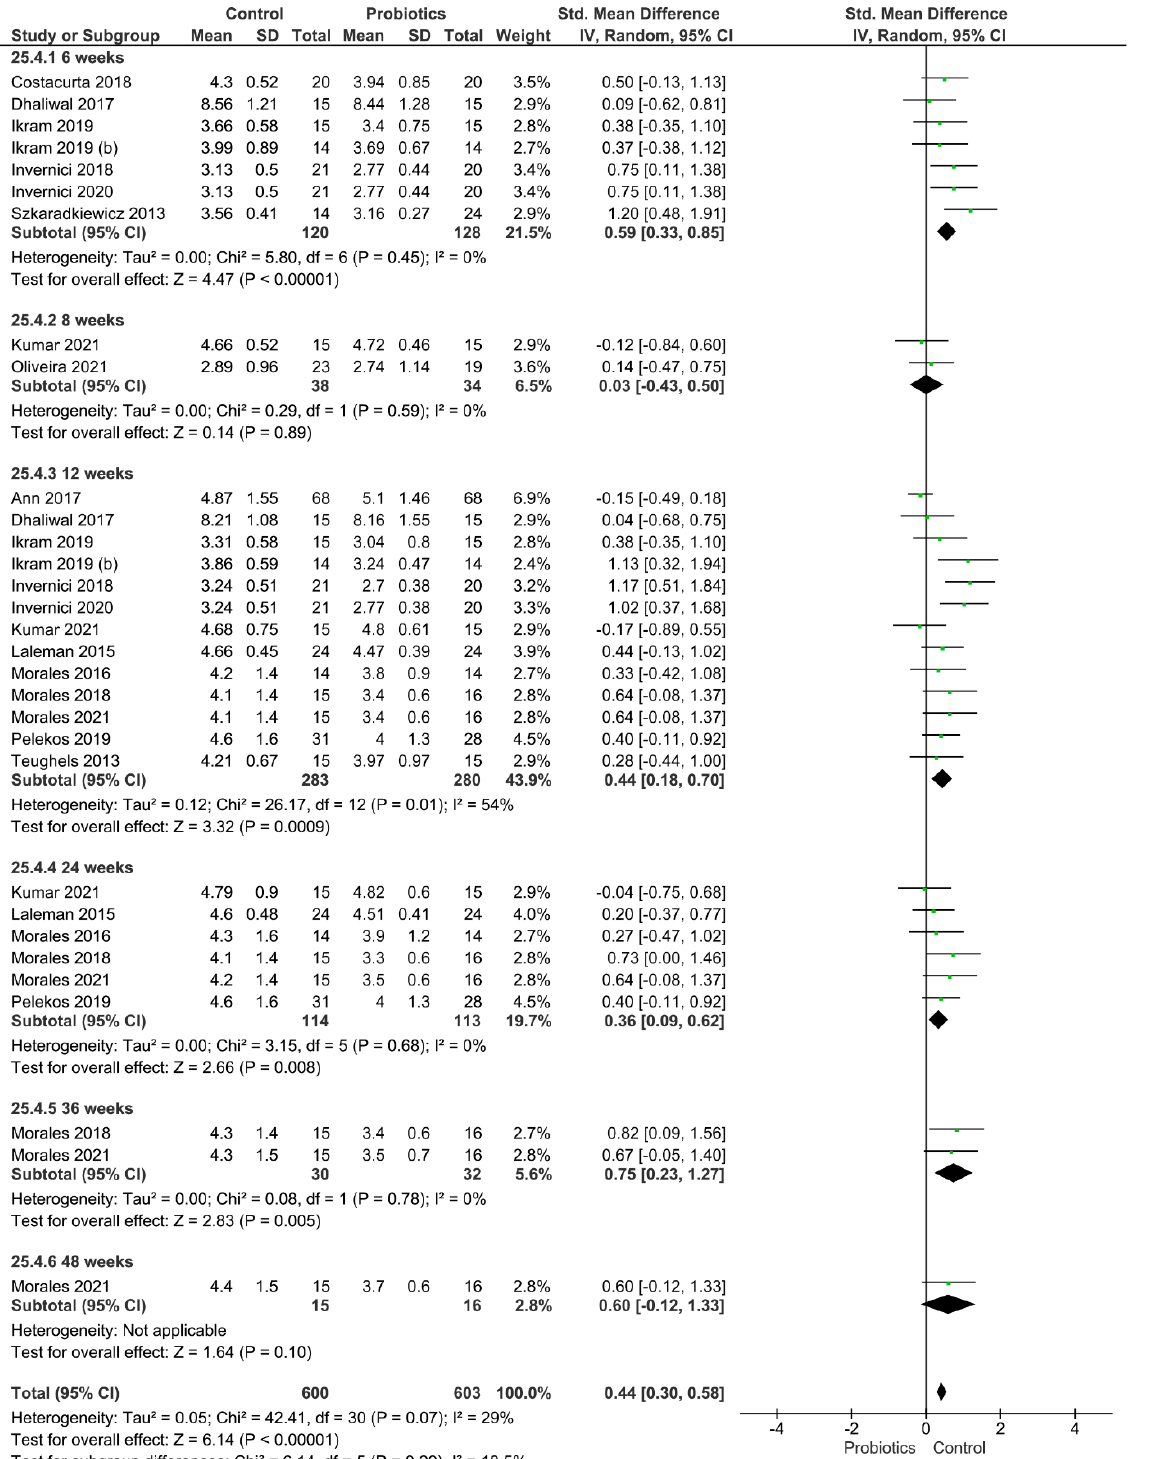
Figure 4. Results from the meta-analysis for the clinical attachment loss parameter.